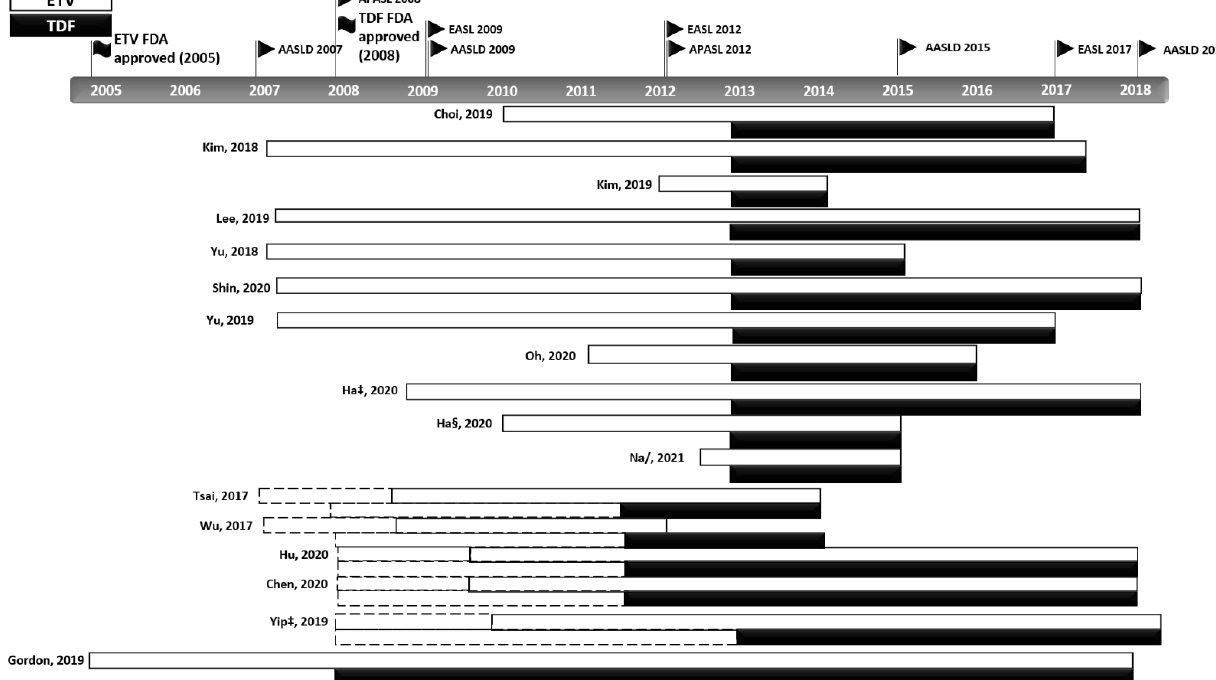
Figure 5. Modifications to the international treatment guidelines for CHB. The various changes and updates to the CHB guidelines and reimbursement policies and differences in the start dates of patient enrolment are shown. Dotted line: drug prescription available; solid line: drug prescription with reimbursement benefits available. ‡ suggest outcomes from competing risk analysis; § Ha from CHA Bundang Medical Center, CHA University;/from unadjusted cohort at the time of CVR [7,23– 32,35–40].